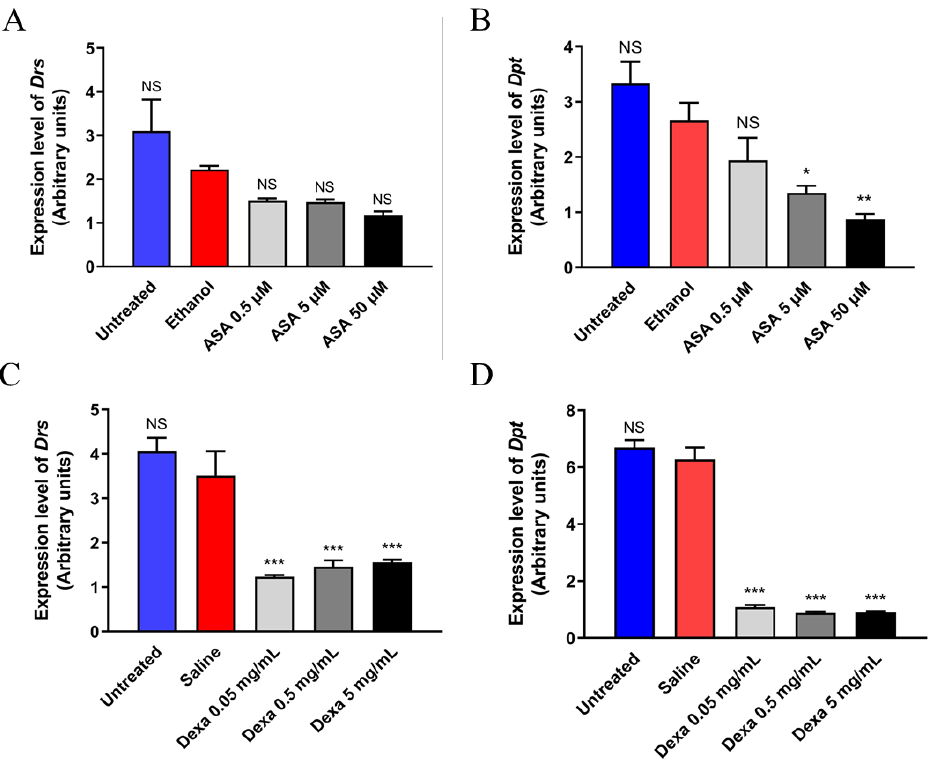
Figure 6. Expression of Drs and Dpt in the adult males of PGRP-LB ∆ in the presence or absence of aspirin ( A , B ) or dexamethasone ( C , D ). For each experiment, adult males of PGRP-LB ∆ at 2–4 days old were maintained at 25 ◦ C in fly food containing the respective drugs. These flies were subjected to total RNA isolation and subsequently followed by RT-qPCR for quantification of Drs and Dpt mRNA levels. The expression level of rp49 was used as the reference control. ASA, Aspirin; Dexa, Dexamethasone; NS, Non-Significant; * p < 0.05; ** p < 0.01; *** p < 0.001.